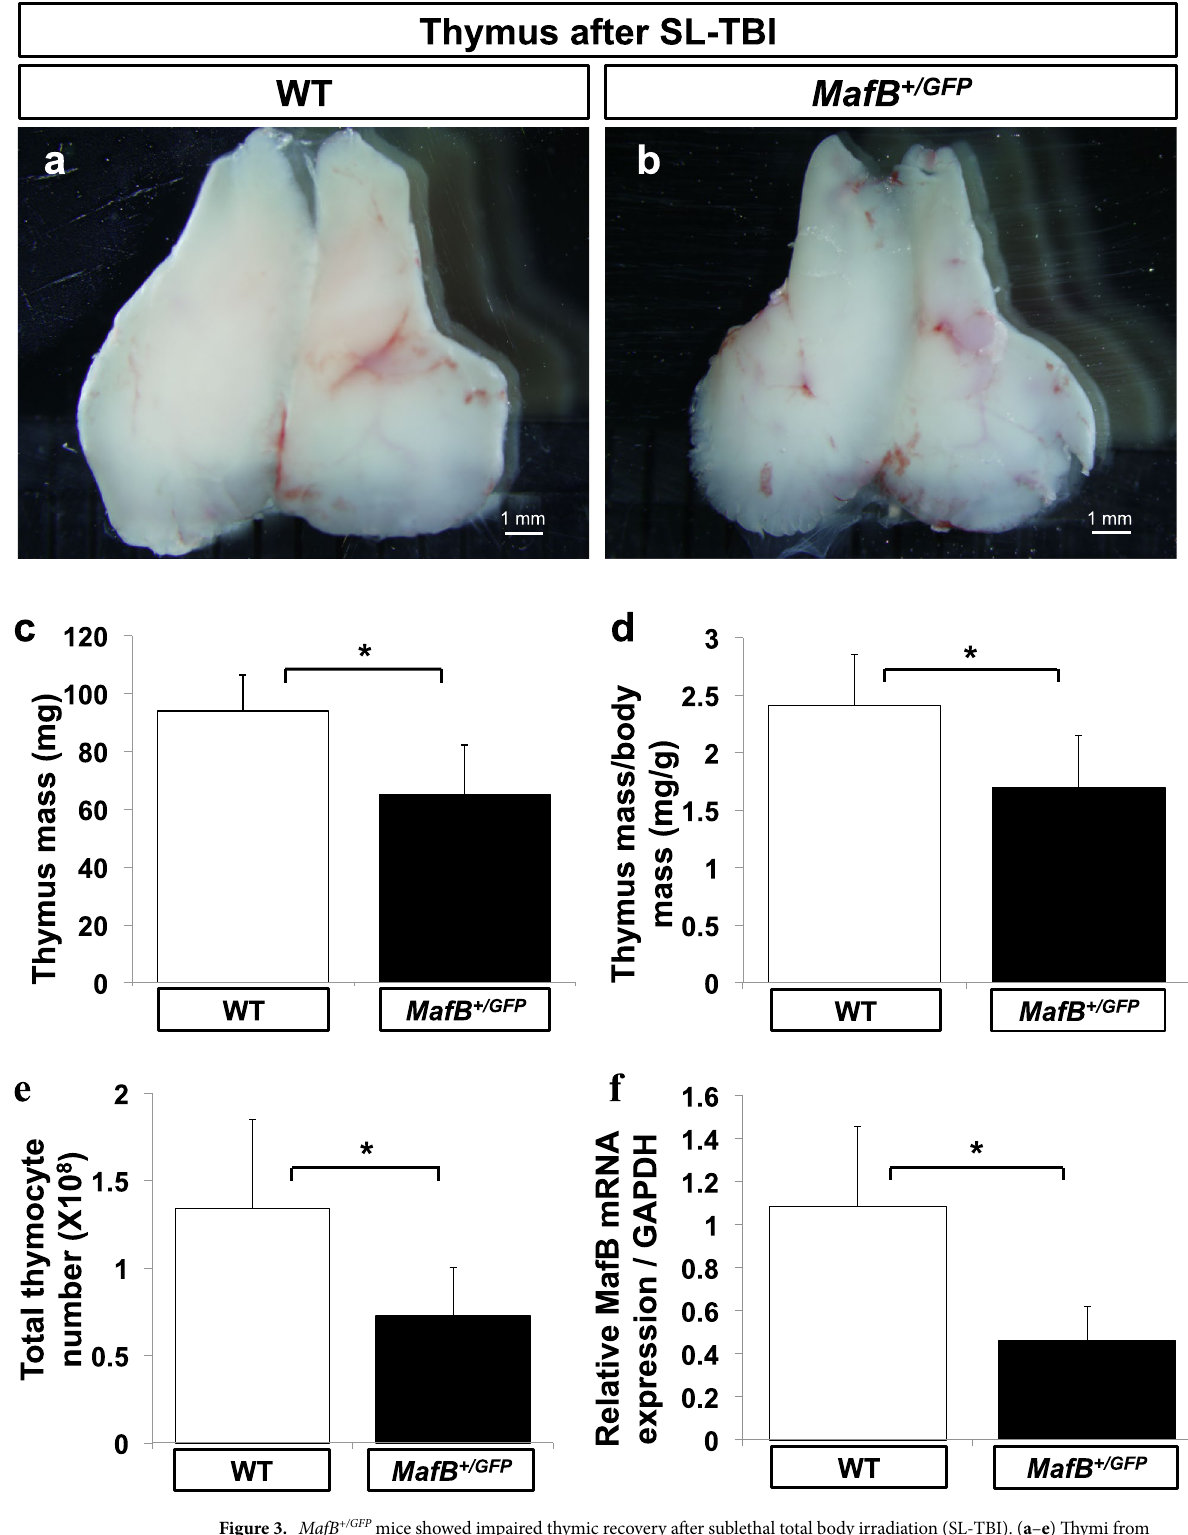
Figure 3. MafB + /GFP mice showed impaired thymic recovery after sublethal total body irradiation (SL-TBI). ( a – e ) Thymi from 9-week-old wild-type (WT) (white bars, n = 6) and MafB + /GFP (black bars, n = 6) mice were analyzed 28 days after SL-TBI. ( a , b ) Gross morphology of thymus. Scale bar: 1 mm. ( c ) Absolute thymus mass (mg; milligrams). ( d ) Normalized mass calculated as thymic mass divided by body mass (mg/g). ( e ) Total thymocyte number, measured using a haemocytometer. All data are shown as the means ± standard deviation (SD). *P < 0.05 (Student’s t test). ( f ) The thymi of MafB + /GFP mice showed reduced MafB mRNA expression compared to those of WT counterparts. Total RNA was extracted from whole thymi of untreated 5-week-old WT (white bar, n = 6) and MafB + /GFP (black bar, n = 6) mice. MafB mRNA expression was subsequently measured by qRT-PCR, and normalized to GAPDH mRNA expression. Data presented as the means ± SD. *P < 0.05 (Student’s t test). All data shown are representative results of at least 3 independent experiments using adult specimens from different litters (n ≥